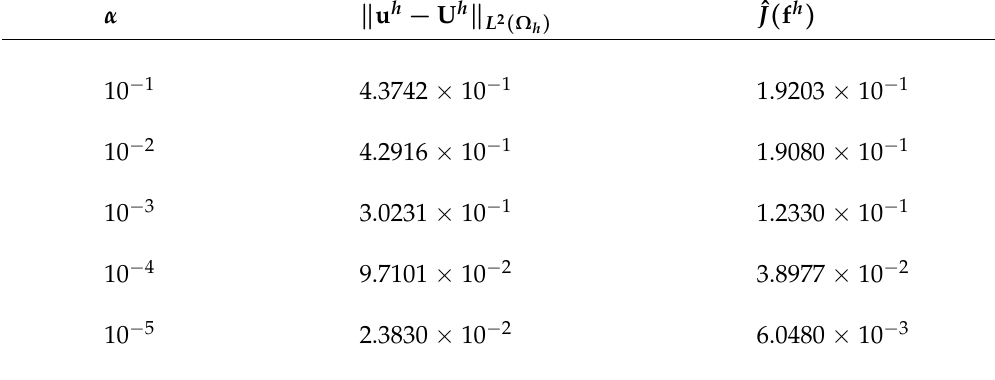
Table 1. Tracking errors on 18 2 mesh.